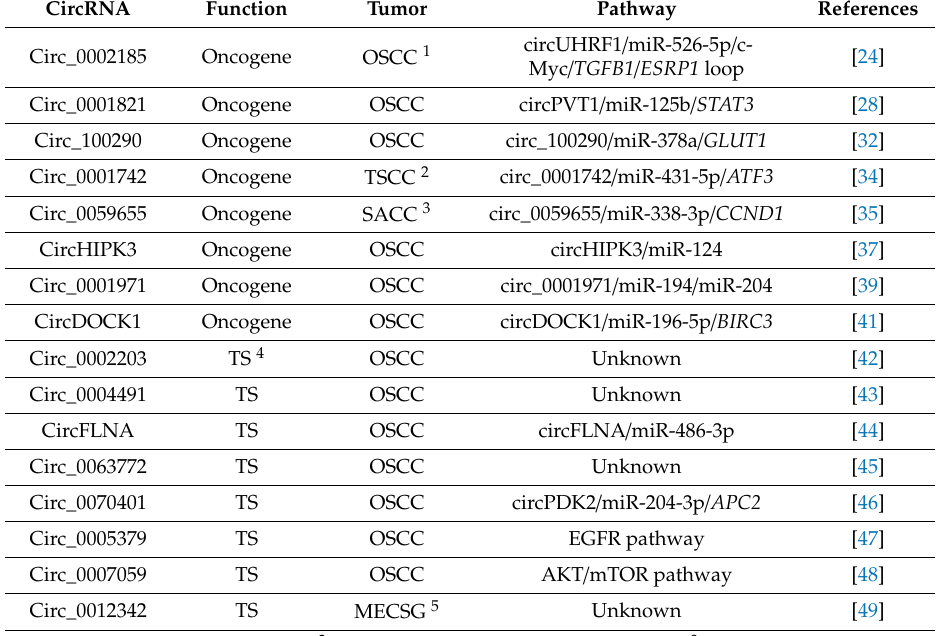
Table 1. Signaling pathways regulated by circRNAs in oral cancer.